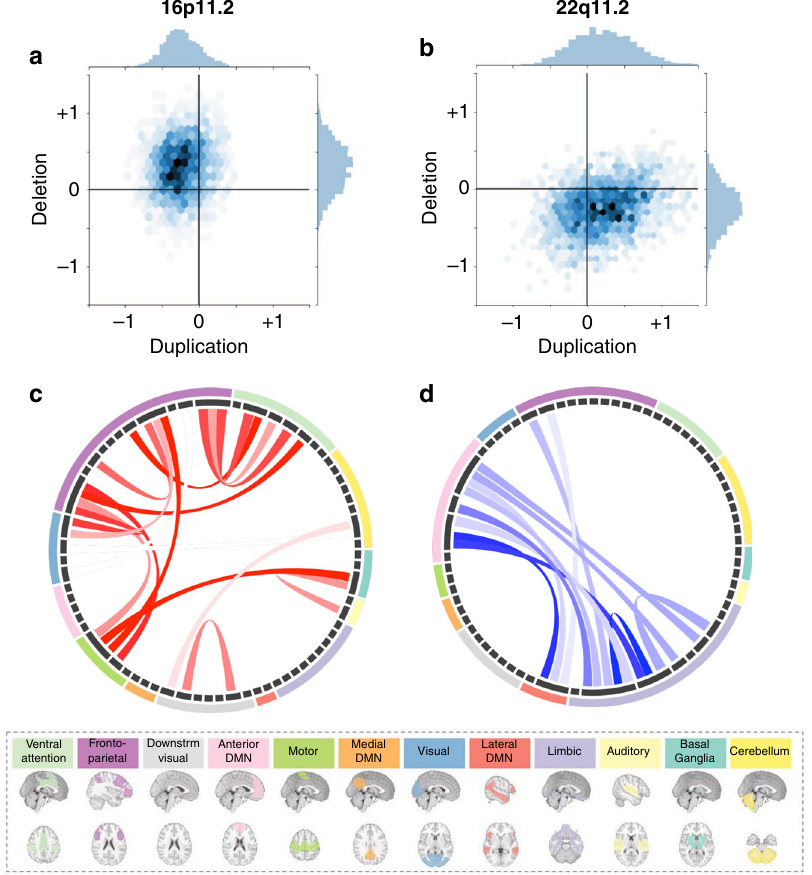
Fig. 1 Connectome-wide effects of CNVs. a , b Scatterplot ( hexagonal plot ), showing estimates (beta values) from connectome-wide association studies (CWAS) performed between 16p11.2 ( a ) and 22q11.2 ( b ) CNVs and their respective controls. In total, 2080 beta estimates were obtained from a linear model computed from z-scored connectomes based on the variance of the respective controls. The color hue represents the number of beta estimates in the hexagon bin. Y -axis: beta values associated with deletions (CWAS comparing deletions vs controls). X -axis: beta-values associated with duplications (CWAS comparing duplications vs controls). c , d Each chord diagram shows the top 20% of connections surviving FDR correction ( q < 0.05) from the 16p11.2 deletion ( c ) and 22q11.2 deletion ( d ) CWAS. Each chord represents a signi fi cantly altered connection between two functional seed regions. All 64 seed regions are represented in the dark gray inner circle. The width of the seed region in the gray inner circle corresponds to the number of altered connections. Seed regions are grouped into 12 functional networks (outer ring, Supplementary Data 1.9). Networks are represented in 12 brains below the two diagrams. Red chords represent overconnectivity and blue chords